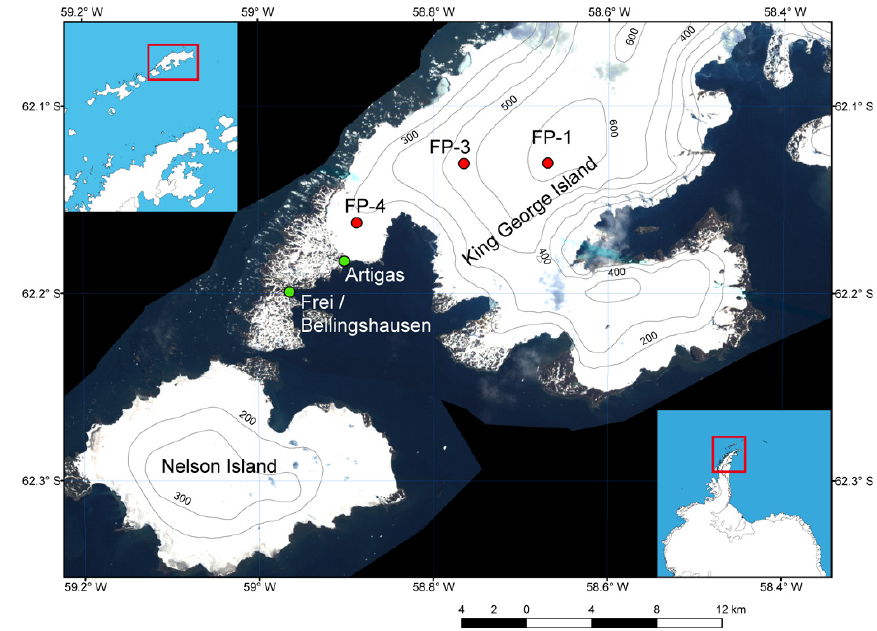
Fig. 4. Overview of the study area on King George Island (KGI), South Shetland Islands. Precipitation samples and meteorological data were collected at the Chilean station Frei and the neighbouring Russian station Bellingshausen; expeditions to the KGI glacier were organized from the Uruguayan station Artigas (green dots). Three firn cores (red dots) were retrieved from this area between the local Bellingshausen dome (FP-4) and the main dome of KGI (FP-1). The Landsat 7 satellite image is available at the LIMA website (http://lima.usgs.gov/). Contour lines shown are from the Antarctic Digital Database (ADD)